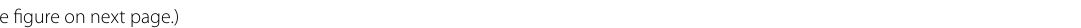
Fig. 2 Influence of circ_0007059 overexpression on the cell viability of IFN‑induced RMC and HEK293 cells. RMC and HEK293 cells were transfected with a circ_0007059‑overexpressing vector or NC vector for 24 h, followed by treatment with 1,000 units/mL IFN for 24 h. A , B Expression level of circ_0007059 in RMC and HEK293 cells was detected by RT‑qPCR (biological replicates, 3; technical replicates, 2; repeat time, 3). C , D A CCK‑8 assay was used to measure the cell proliferation rate at 24, 48, and 72 h after transfection (biological replicates, 1; technical replicates, 3; repeat time 3). E , F An MTT assay was used to determine cell viability, whereas untreated cells served as controls (biological replicates, 1; technical replicates, 3; repeat time, 3). Results are expressed as the